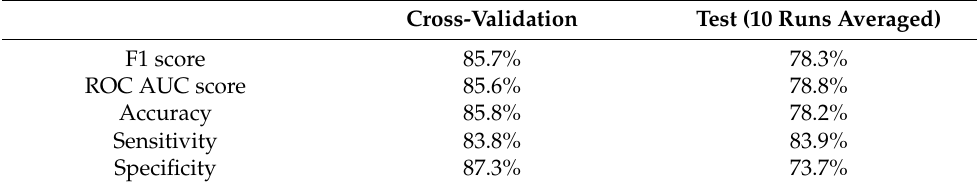
Table 14. Cross-validation and test scores for Configuration